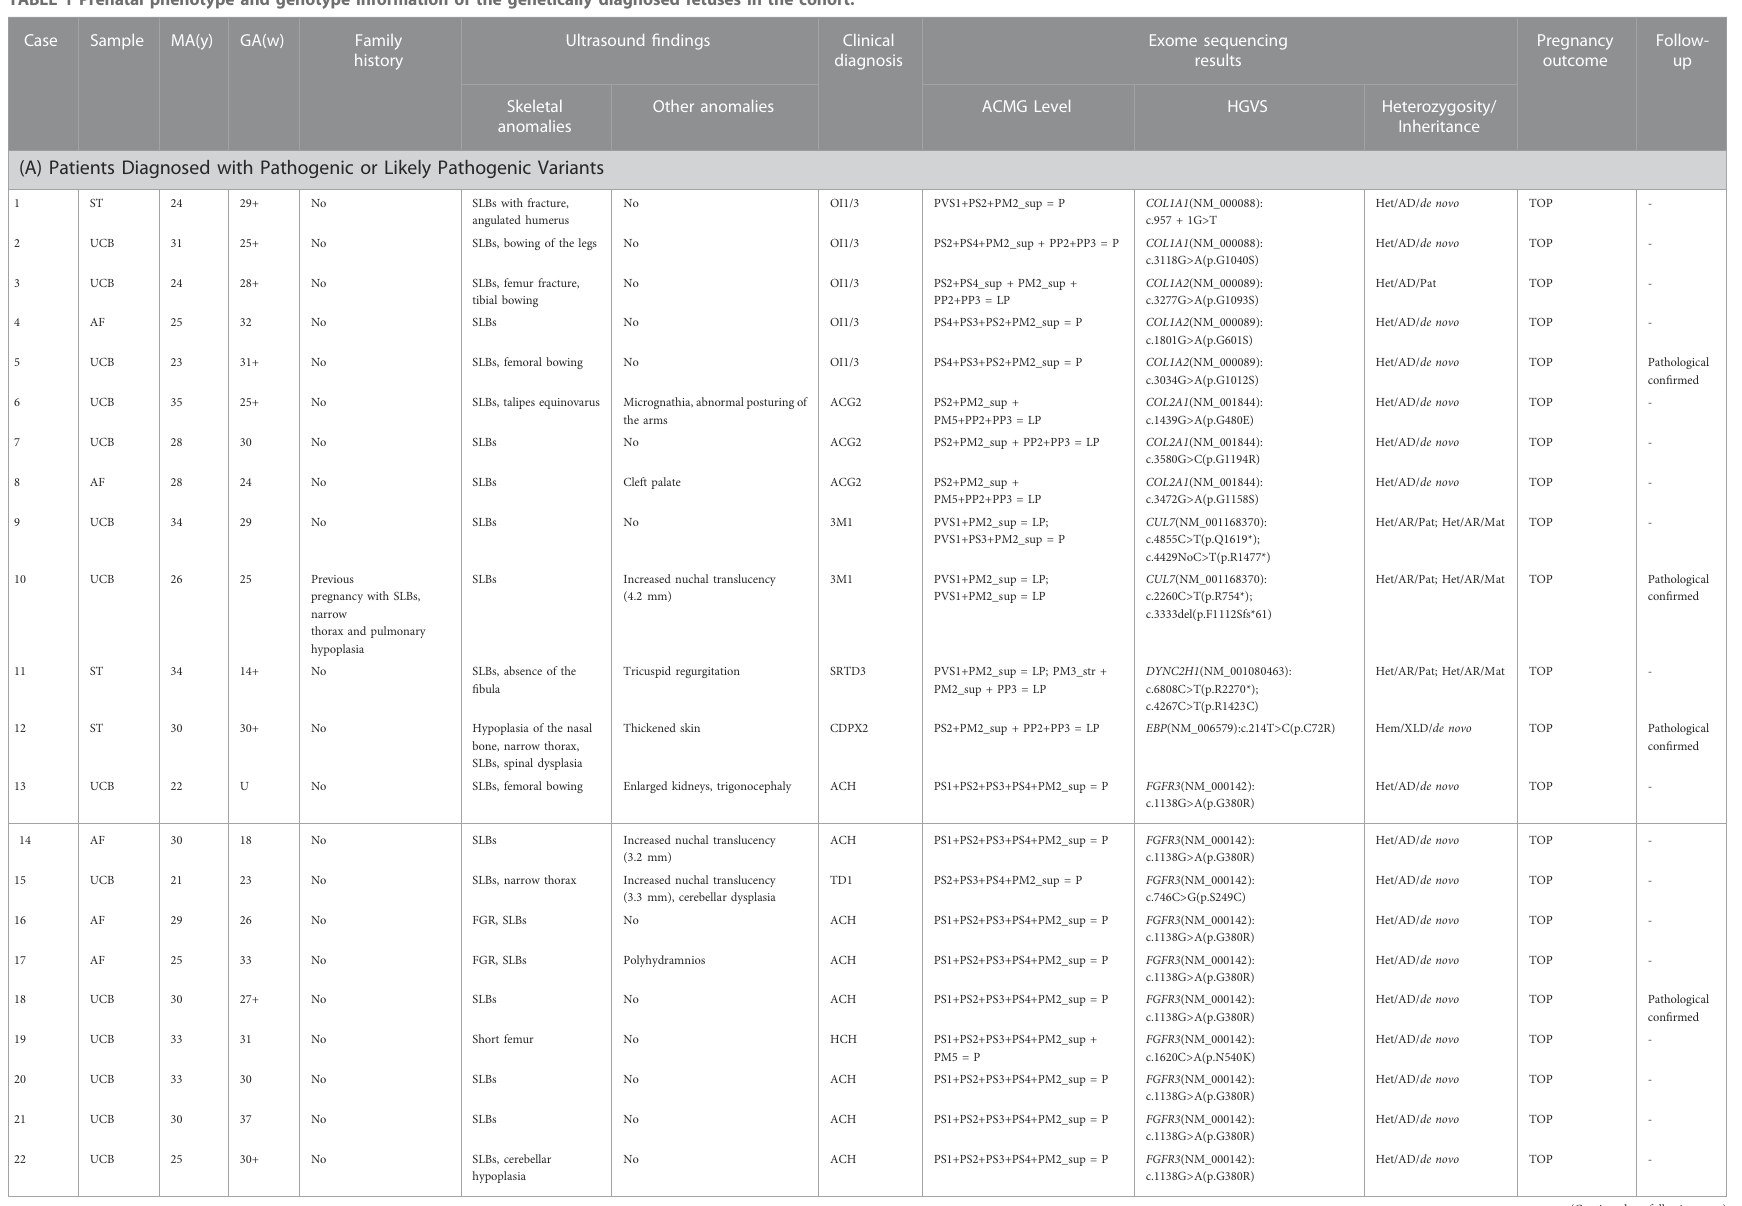
TABLE 1 Prenatal phenotype and genotype information of the genetically diagnosed fetuses in the cohort.